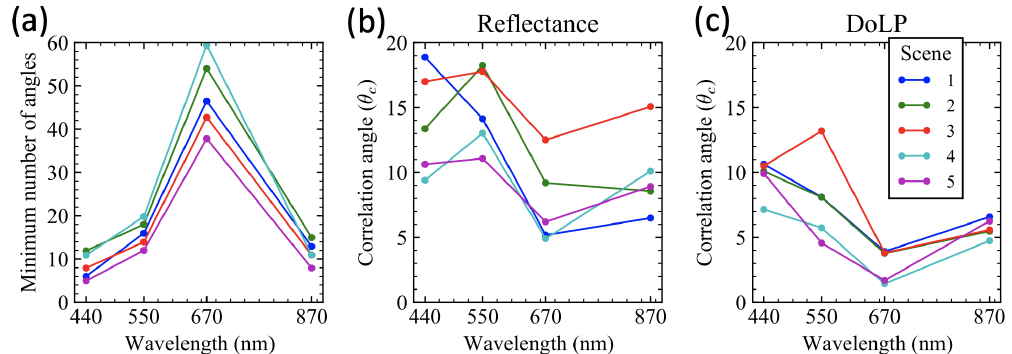
Figure 15. (a) The minimal number of angles used to estimate correlation parameters from each scene and wavelength; (b, c) the estimated correlation